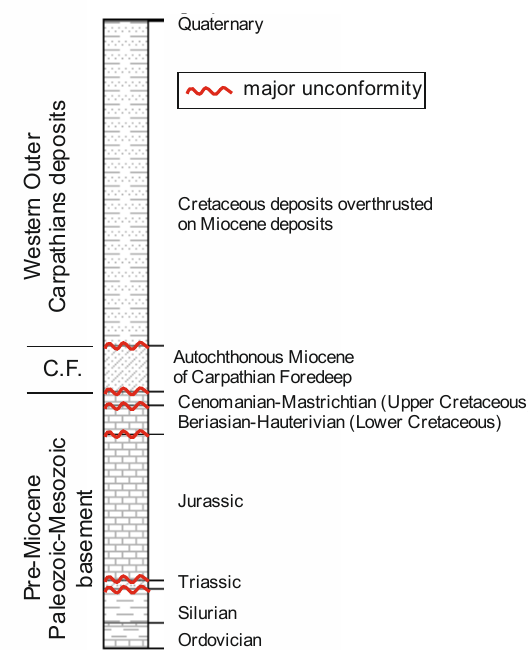
Figure 3. Stratigraphic column of the Pilzno-40 well. Below the very thin Quaternary sediments, there are flysch deposits of the Skole Unit, which consist of shales (siltstones) and sandstones that represent the Inoceramus Beds of the Upper Cretaceous. The flysch strata are thrust over the sandy-clayey Miocene series (Upper Badenian) of the Zgłobice Unit. The pre-Miocene basement consists of epicontinental Cretaceous marls resting on Upper Jurassic marls and limestones. Below the Jurassic, there are clastic sandy-clayey beds of the Lower Triassic (Buntsandstein-middle part), which in turn rest on Silurian graptolitic shales (Wenlock) and Ordovician (Llandeil-Caradocian) carbonates [49,65,67]. C.F. Carpathian Foredeep. Note that several significant unconformities occur in the sedimentary succession of the study area. These represent periods of substantial erosion.